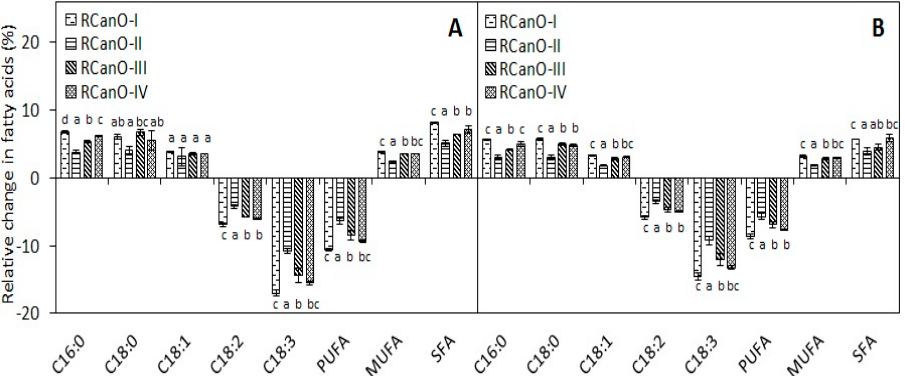
Figure 4. Changes in selected fatty acids in canola oils during 36 and 48 frying cycles: ( A ) 2016 / 2017 ( n = 36) and ( B ) 2017 / 2018 ( n = 48) production seasons; PUFA, polyunsaturated fatty acid; MUFA, monounsaturated fatty acid; SFA, saturated fatty acid; and IV, iodine value. Different letters show means that are statistically significant from each other ( p < 0.05).